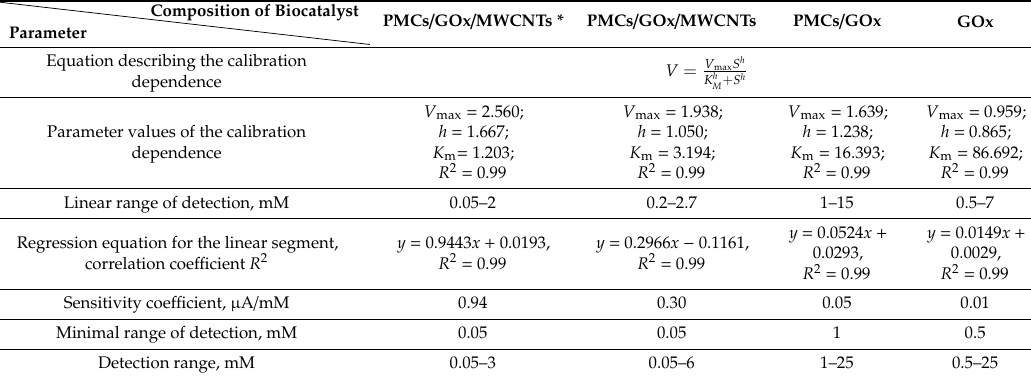
Figure 6. Calibration dependences of biosensor signals vs. glucose concentrations at various modifications of the electrode: 1, PMCs / GOx / MWCNTs in the hollow; 2, PMCs / GOx; 3, GOx; and 4, PMCs / GOx / MWCNTs in the hollow plus an additional modification of the electrode with MWCNTs (see explanations in the text). Table 2. Basic analytical characteristics of biosensors.